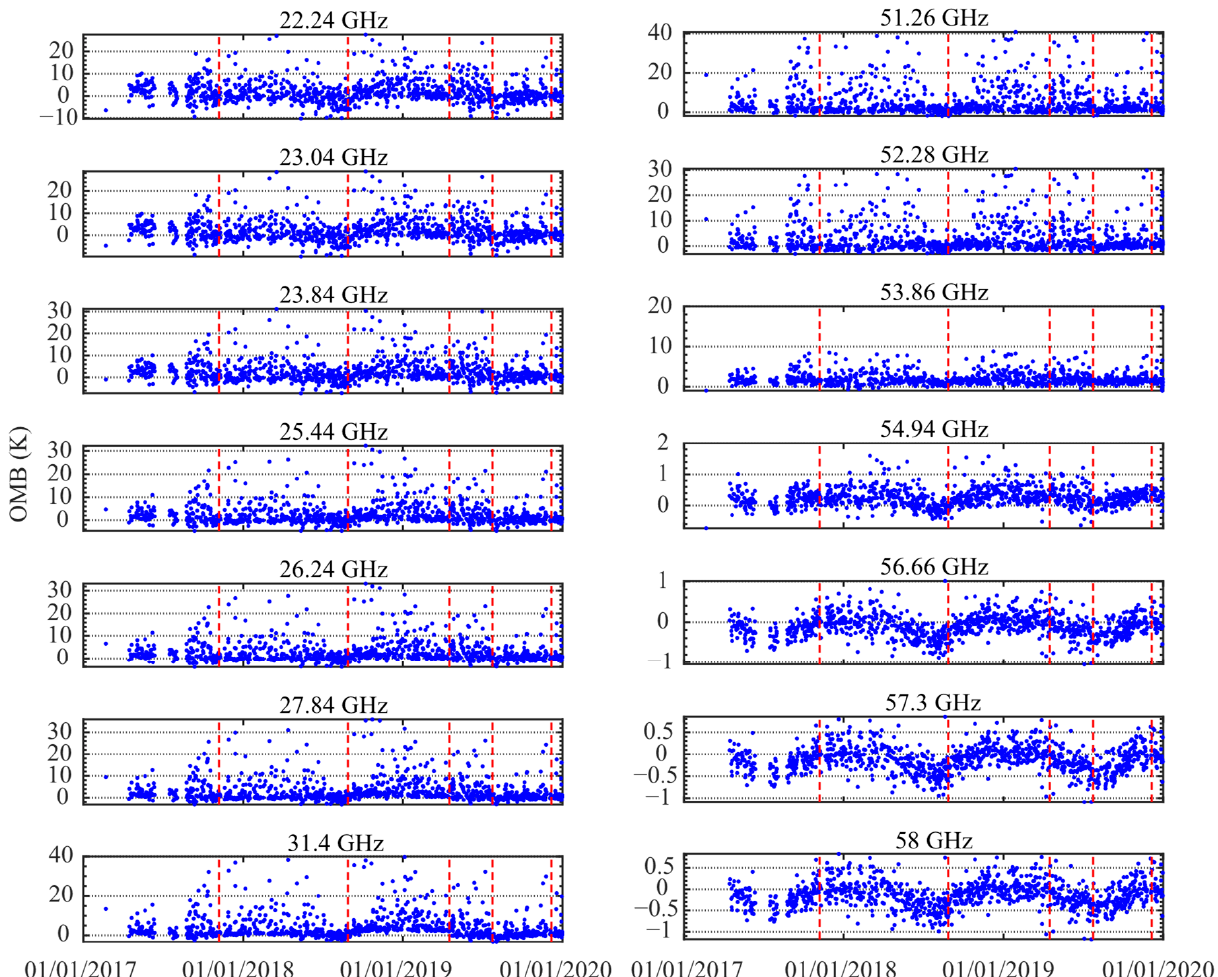
Figure 4. Time series diagrams of OMB of 14 channels in the no-precipitating cloudy weather (the red dashed lines are the dates of MWR calibration).